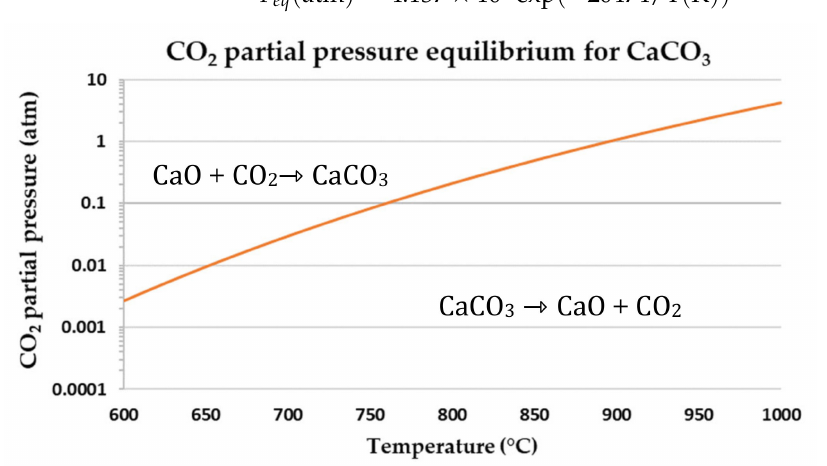
Figure 6. Equilibrium partial pressure of CO 2 from CaCO 3